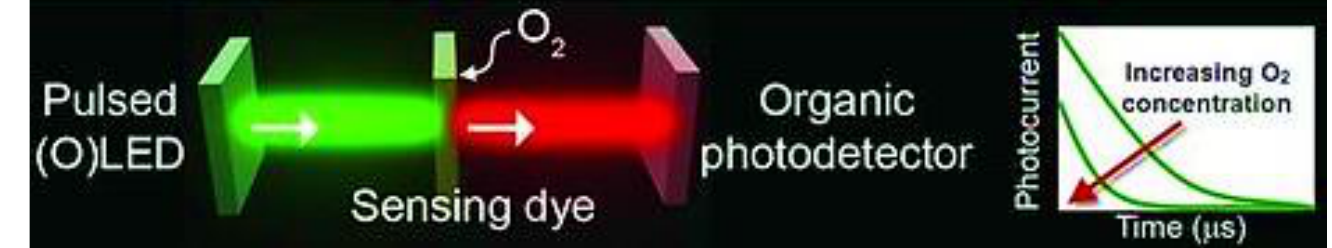
Figure 3. Organic light-emitting diode setup [56]. Reproduced with permission from Wiley.